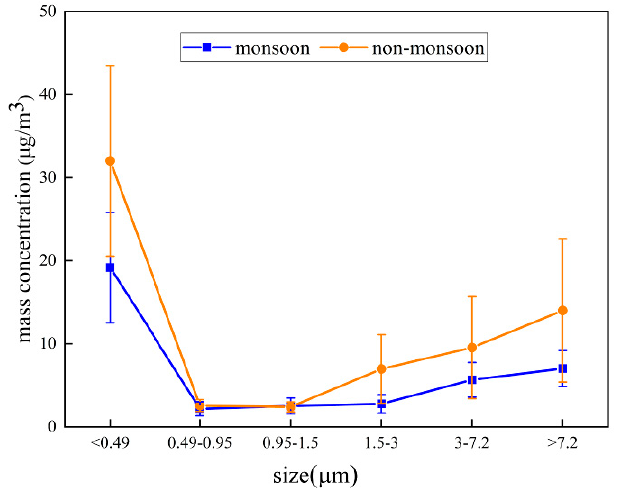
Figure 3. The size distribution of atmospheric particulate matter (PM) mass concentration during the monsoon and non-monsoon seasons.